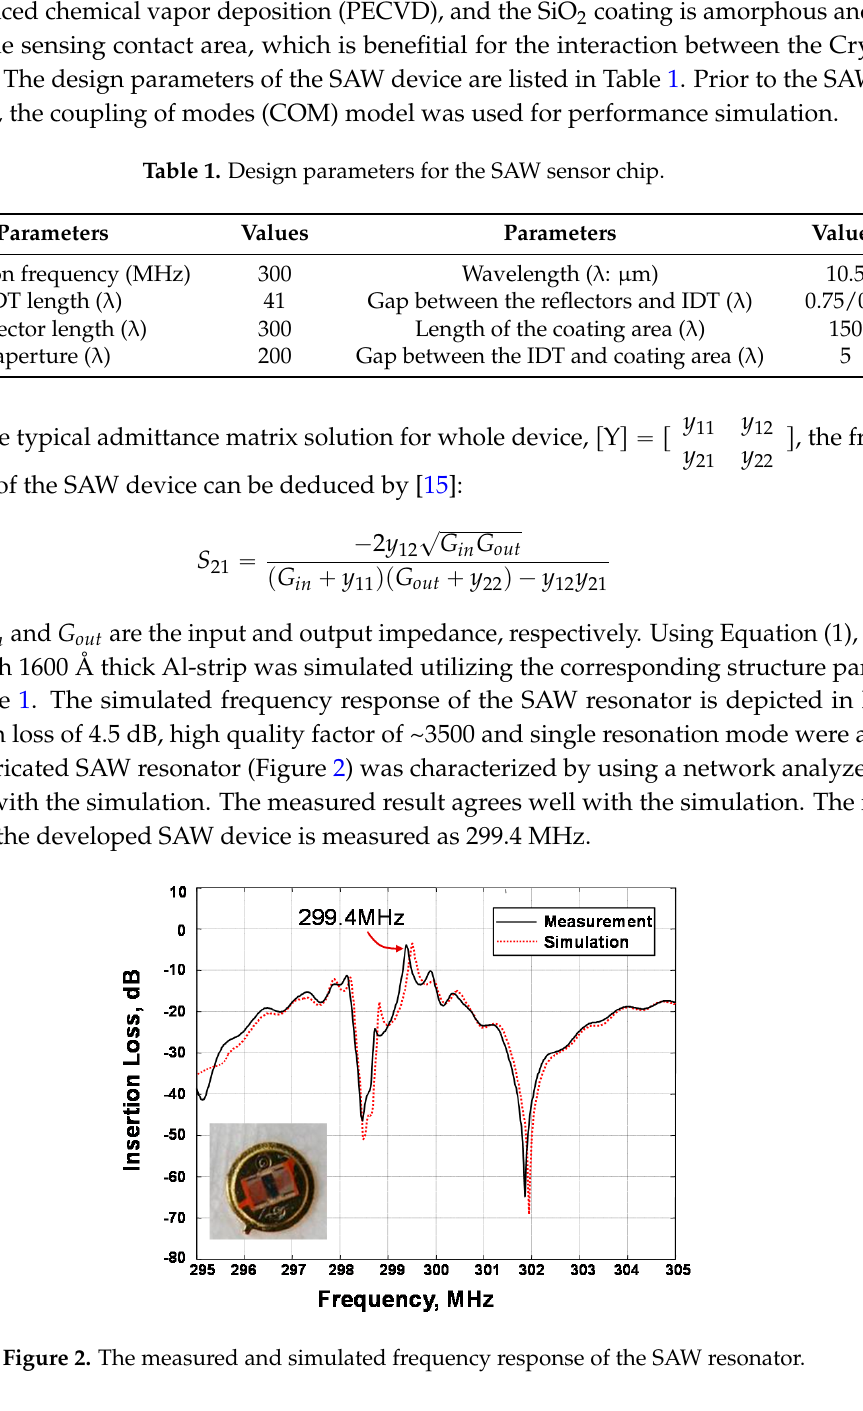
Table 1. Design parameters for the SAW sensor chip.